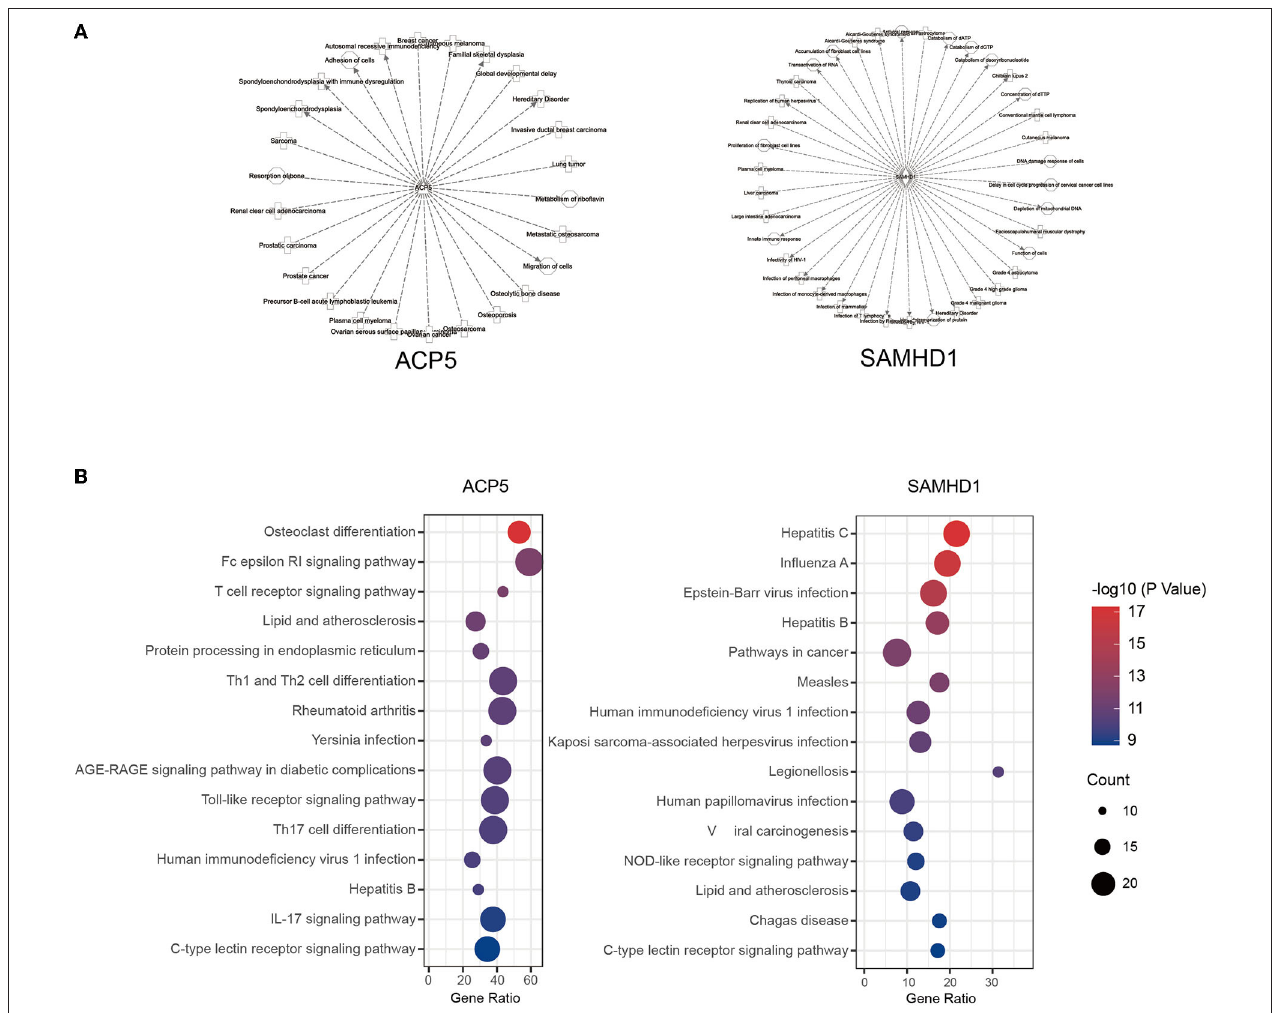
FIGURE 3 | The potential regulation of ACP5 and SAMHD1 in SLE. The phenotype-gene relationship (A) and pathway analysis (B) were shown to be associated with immunity responses.